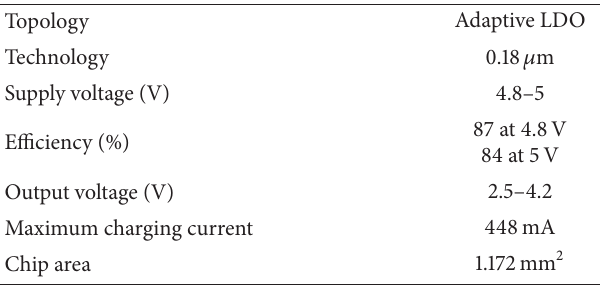
Table 1: Summary of simulation